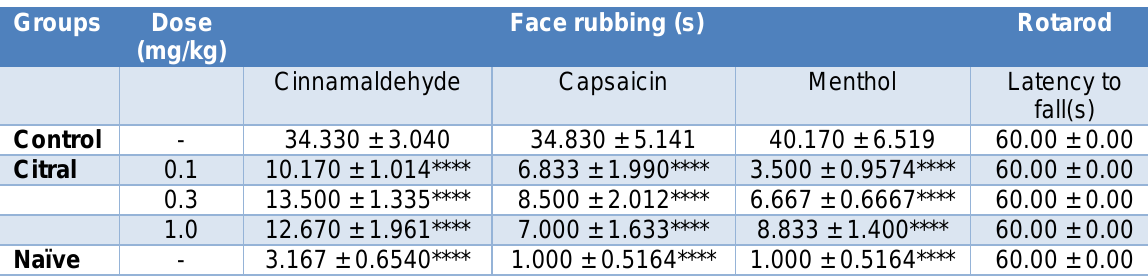
Table 2: Effect of citral on cinnamaldehyde, capsaicin and menthol nociception in mice